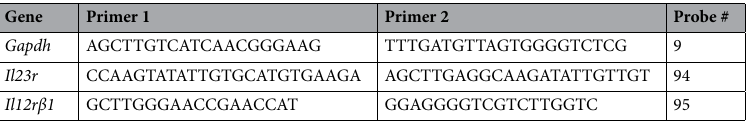
Table 1. Primer sequences and probes used for